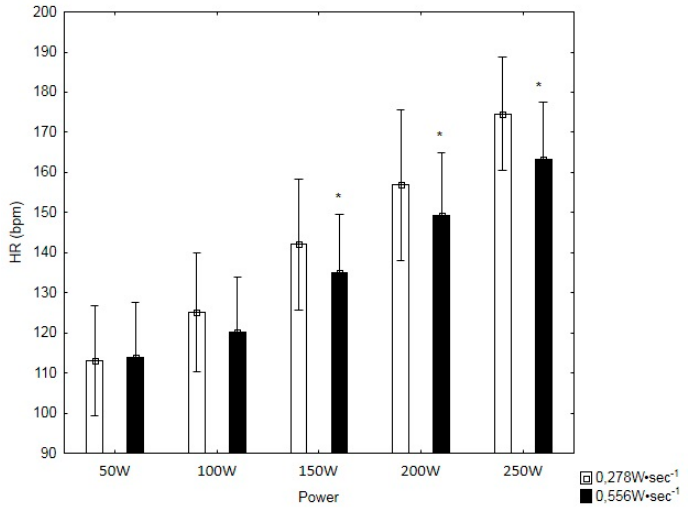
Figure 2. The submaximal heart rate (HR) values in power 50–250 W. *—statistically significant difference between tests ( p < 0.05).